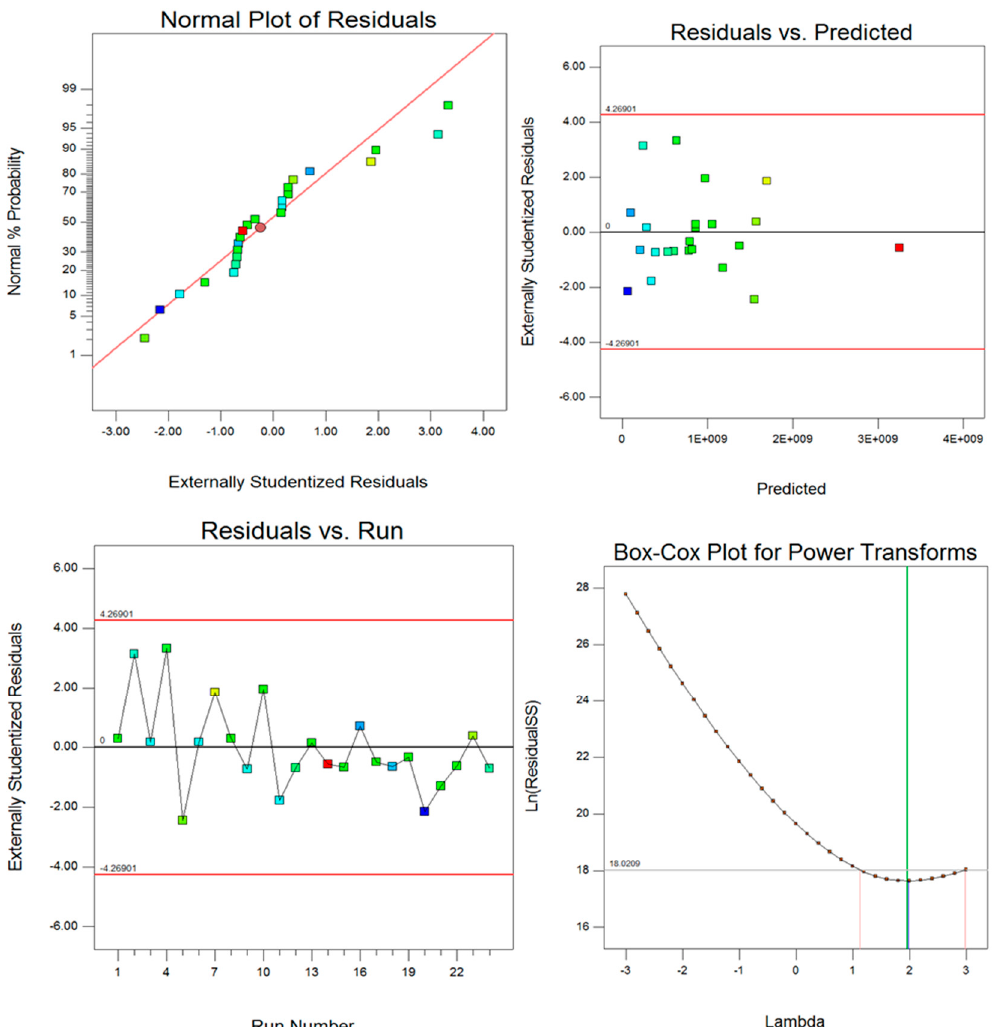
Figure 13. Post ANOVA verification tools for the prediction of energy absorption. Post ANOVA verification leads to the generation of an empirical model to predict each response in the range span of every defined factor in Table 2. Equations (2) and (3) are the un-coded proposed models to predict the energy absorption and peak load for FCS and PFCS panels.